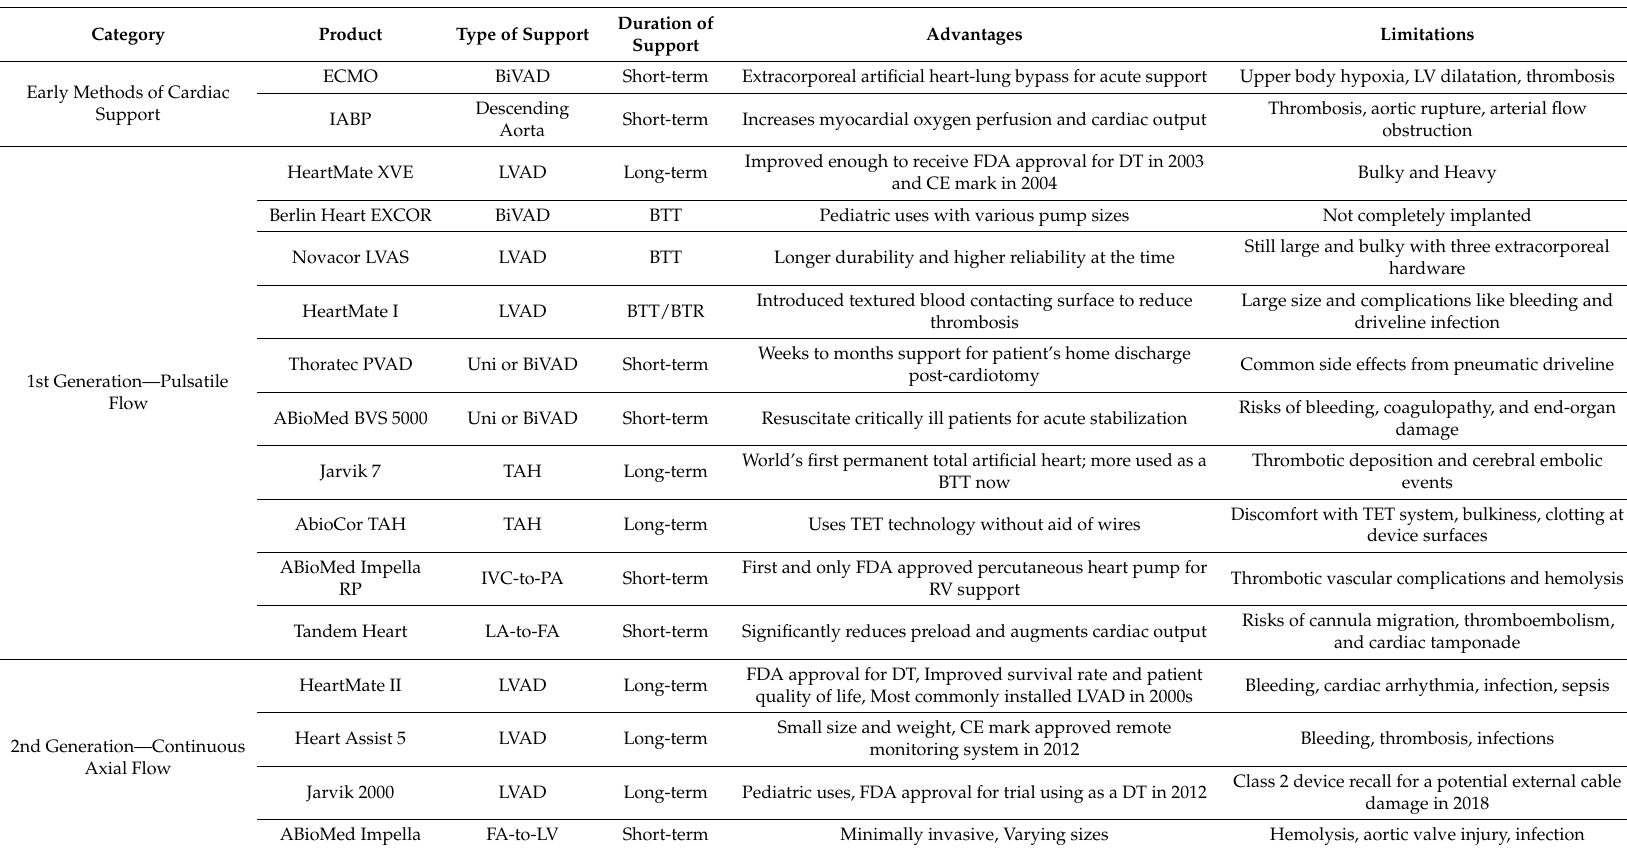
Table 1. Commonly used cardiac assist devices and their key characteristics (*IVC: inferior vena cava, FA: femoral artery, LA: left atrial, PA: pulmonary artery)